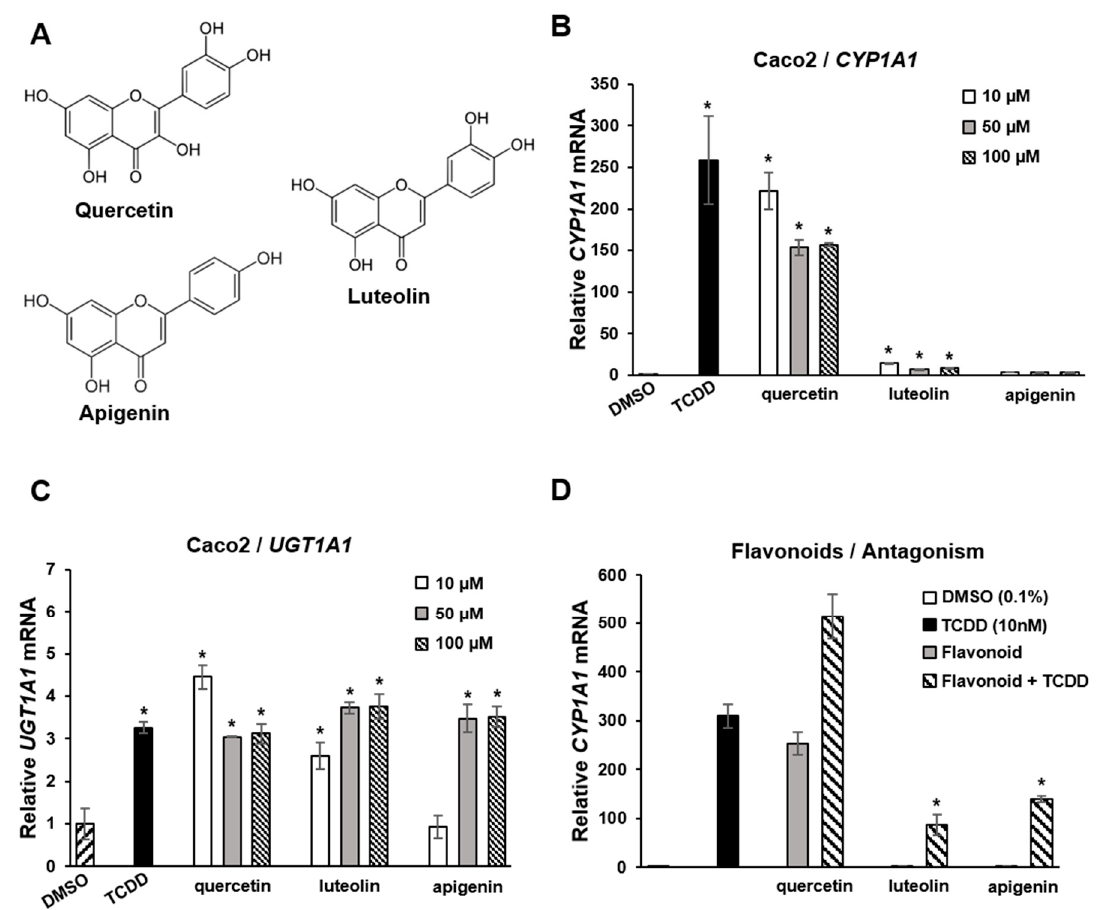
Figure 4. Flavoniods as SAhRMs. ( A ) Flavonoid structure. ( B ) TCDD and quercetin-induced CYP1A1 in Caco2 cells, luteolin and apigenin exhibited minimal to non-detectable activity, respectively. TCDD, quercetin, luteolin and apigenin induced UGT1A1 ( C ) and luteolin and apigenin, but not quercetin-inhibited induction of CYP1A1 by TCDD in Caco 2 cells ( D ) [111]. Significant ( p < 0.05) induction ( B , C ) or inhibition of TCDD-induced CYP1A1 ( D ) is indicated